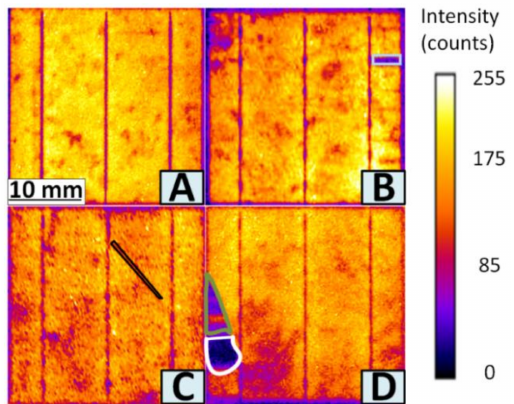
Figure 1. EL cell images inflicted with di ff erent faults: ( A ) no failures; ( B ) finger failures (region marked with light blue); ( C ) micro-crack Mode A (black); ( D ) cracks Mode B (olive green) and Mode C (white).